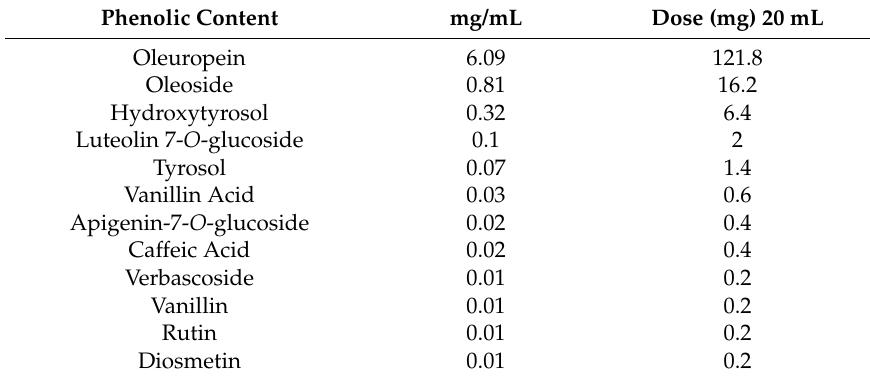
Table A3. Phenolic content in Comvita OLE (HPLC performed by Alistair Binney from the Comvita team. The placebo was also run for quality control and no polyphenols were detected).